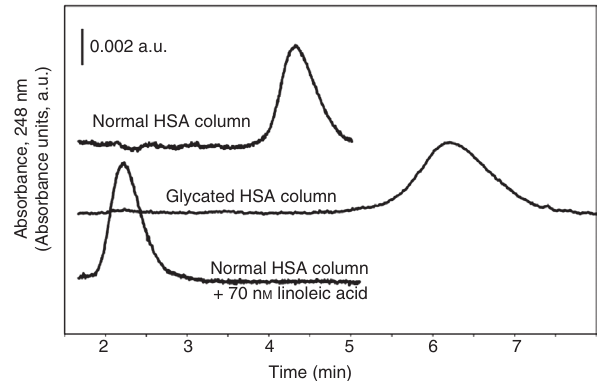
Figure 10 Zonal elution experiments examining the retention of acetohexamide on 2.0 cm × 2.1 mm i.d. HPAC columns containing normal HSA or glycated HSA at 0.5 mL/min and in the presence of pH 7.4 buffer or pH 7.4 buffer containing 70 nm linoleic acid (Basiaga and Hage 2010).